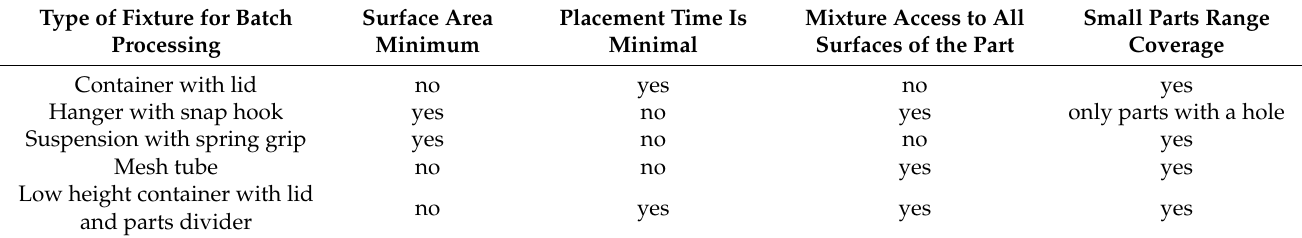
Table 1. The choice of a rational option for placing